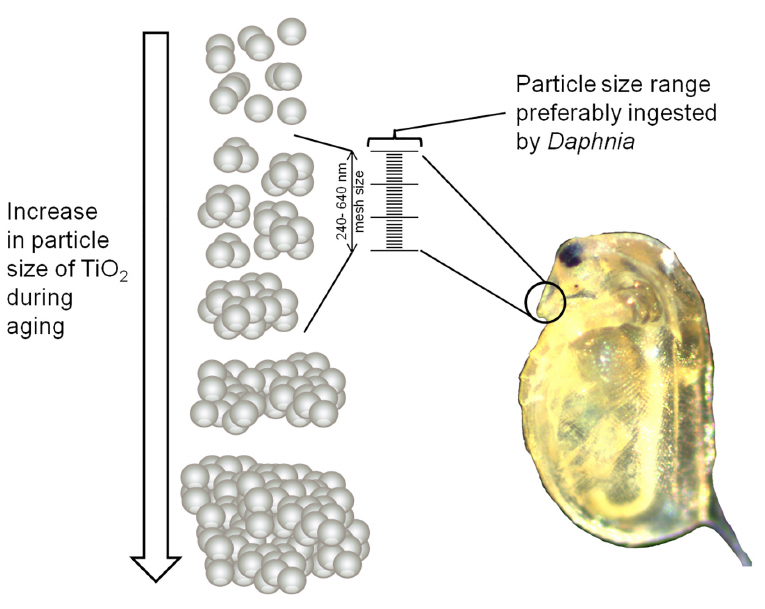
Fig 4. Particle uptake of Daphnia . Schematic draft of the preferably ingested particle size range of Daphnia magna